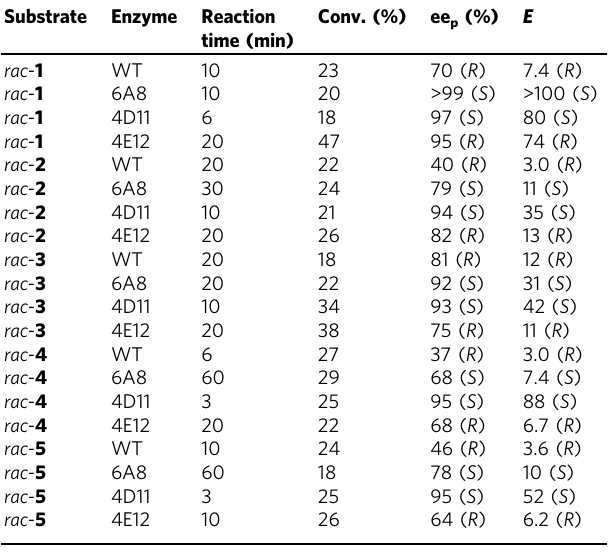
Table 1 Hydrolytic kinetic resolution of different substrates using ( S ) - selective and ( R ) - selective AFEST mutants Substrate Enzyme Reaction Conv. (%) ee p (%) time (min)